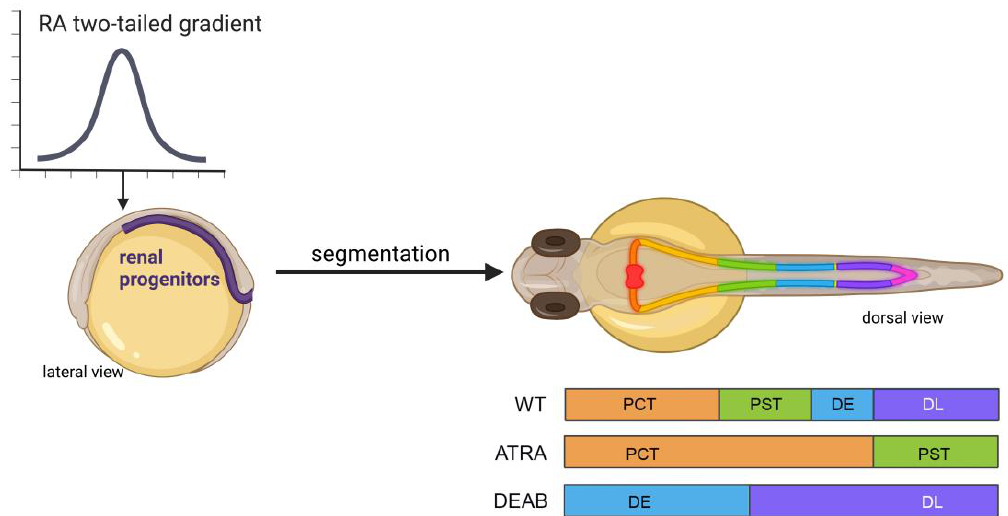
Figure 3. RA levels influence proximo-distal nephron fates during embryonic kidney development in the zebrafish. ( Left ) Renal progenitors are exposed to a gradient of RA during gastrulation and axis formation, with the highest level at the rostral-most locations (arrow). (Right , top ) As develop- ment proceeds, these RA levels exert an influence on the proximo-distal segmentation patterning. The zebrafish embryonic kidney comprises two bilateral nephrons with several unique cell popula- tions, and these undergo morphogenesis events by the 48 stage to connect rostrally at a single mid- line blood filter and caudally at the cloaca where waste exits the body. ( Right , bottom ) The effects of RA are best understood for the 4 main tubule populations: the proximal convoluted tubule (PCT), proximal straight tubule (PST), distal early (DE), and distal late (DL). Embryos exposed to a high dosage of ATRA starting at 60% epiboly form nephrons with only proximal segments. Conversely, embryos exposed to the RA biosynthesis inhibitor DEAB starting at 60% epiboly form nephrons with only distal segments. Figure created with BioRender.com and based on [175]. 3.3. Heart From its genesis, the zebrafish heart is reliant on RA for correct spatial patterning of progenitors. Work performed by Keegan et al. delicately described both RA addition and the time in which RA is necessary for restricting progenitor fates [187]. When they treated embryos with a pan-RAR antagonist and then assessed cmlc2 and nkx2.5 expression, which marking cardiomyocytes precardiac mesoderm, respectively, they observed in- creased domains of expression at the 16-somite stage, suggesting RA works in restricting cardiac cell fates in post gastrulation fish [187]. This hypothesis was then confirmed through the use of exogenous ATRA treatments spanning a time point straddling gastru- lation initiation leads to lessened cmlc2 expression at the 18-somite stage [187]. The mech- anism of RA restricting the cardiac field was further characterized as being mediated by cdx4 and cdx1a expression. In this process, much like in hindbrain development, RA works through downregulating cdx4 expression, thereby activating cyp26a1 expression to metab- olize RA within the cell [188,189]. This hypothesis further postulates the intricate nature of RA self-regulation, as RAREs exist as regulatory units of cyp26/Cyp26/CYP26 family expression [116,117]. Other work involving regulators of cardiac cell fate such as NR2F have been found to have RARES within these factors ’ promoter regions, which in the pres- ence of DEAB leads to a decreased nr2f1a domain. The loss of nr2f1a/b contributes to a relative expansion of the nkx2.5 domain, a commonality seen with RAR antagonism. Further investigation into RA and its role in early heart field regulation revealed that RA works indirectly through the homeobox gene hoxb5b to limit cardiac progenitor pop- ulations [190]. Other work established that RA and FGF signaling worked in opposing manners to regulate heart field establishment, as the heat shock resulting in overexpres- sion of FGF machinery in late gastrulation led to increased cardiac cell count, a phenotype also seen in DEAB-treated embryos [191,192]. Similarly, Aldh2 null mouse embryos bear